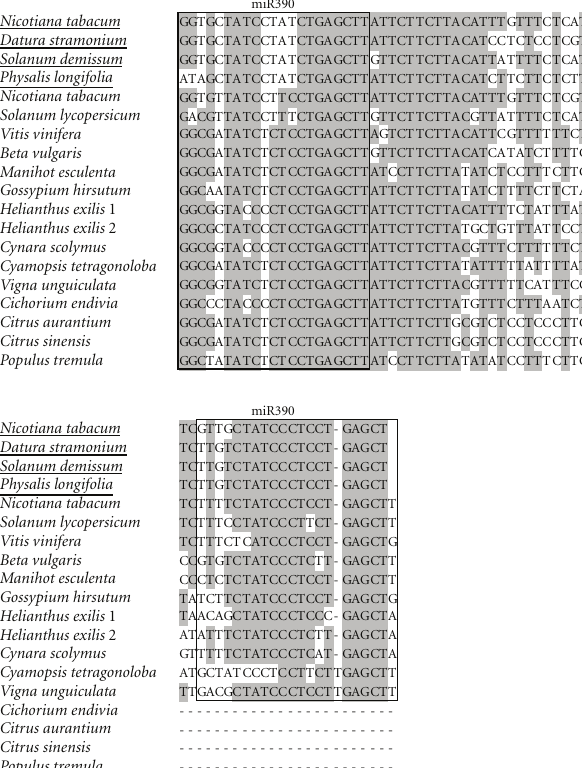
Figure 3: Nucleotide sequence alignment of “170-nt-long” ta-siARF loci of dicot plants. Sequences of Nicotiana tabacum, Datura stramonium , Solanum demissum, and Physalis longifolia (undelined) were determined in this study the others were from GeneBank. Boxes indicate miR390 complementary sites and ta-siARF-encoding sequence regions. The length of nonconserved sequence between the ta-siARF sequence and 3 (cid:2) -miR390 complementary site not included in the alignment is indicated. Dashes in the sequences of Cichorium endivia , Citrus aurantium , Citrus sinensis, and Populus tremula indicate the sequence region lacking the 3 (cid:2) -miR390 complementary site that could not be aligned with other sequences. Shading shows residues identical for the given position in most sequences. Sequences of N. tabacum, D. stramonium , S. demissum, and P. longifolia miR390 complementary sites originate from primers used for the amplification of ta-siARF loci. GeneBank accession numbers of the sequences included in the alignment are as follows: Nicotiana tabacum , FJ804743; Datura stramonium